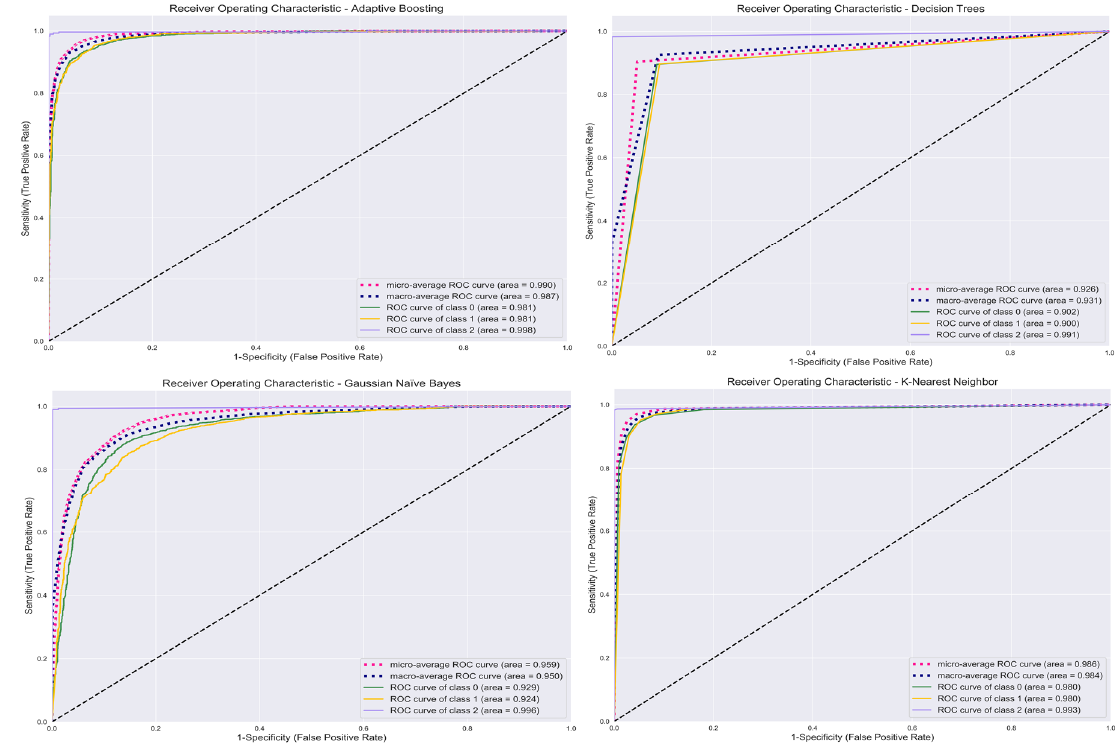
Figure 6. Performance evaluation using ROC for AB, DT, GNB, and KNN.